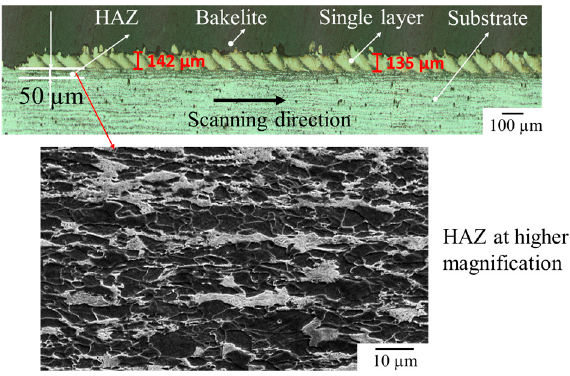
Figure 9. Photography of a cross-section of an etched single deposited layer and HAZ in higher magnification.